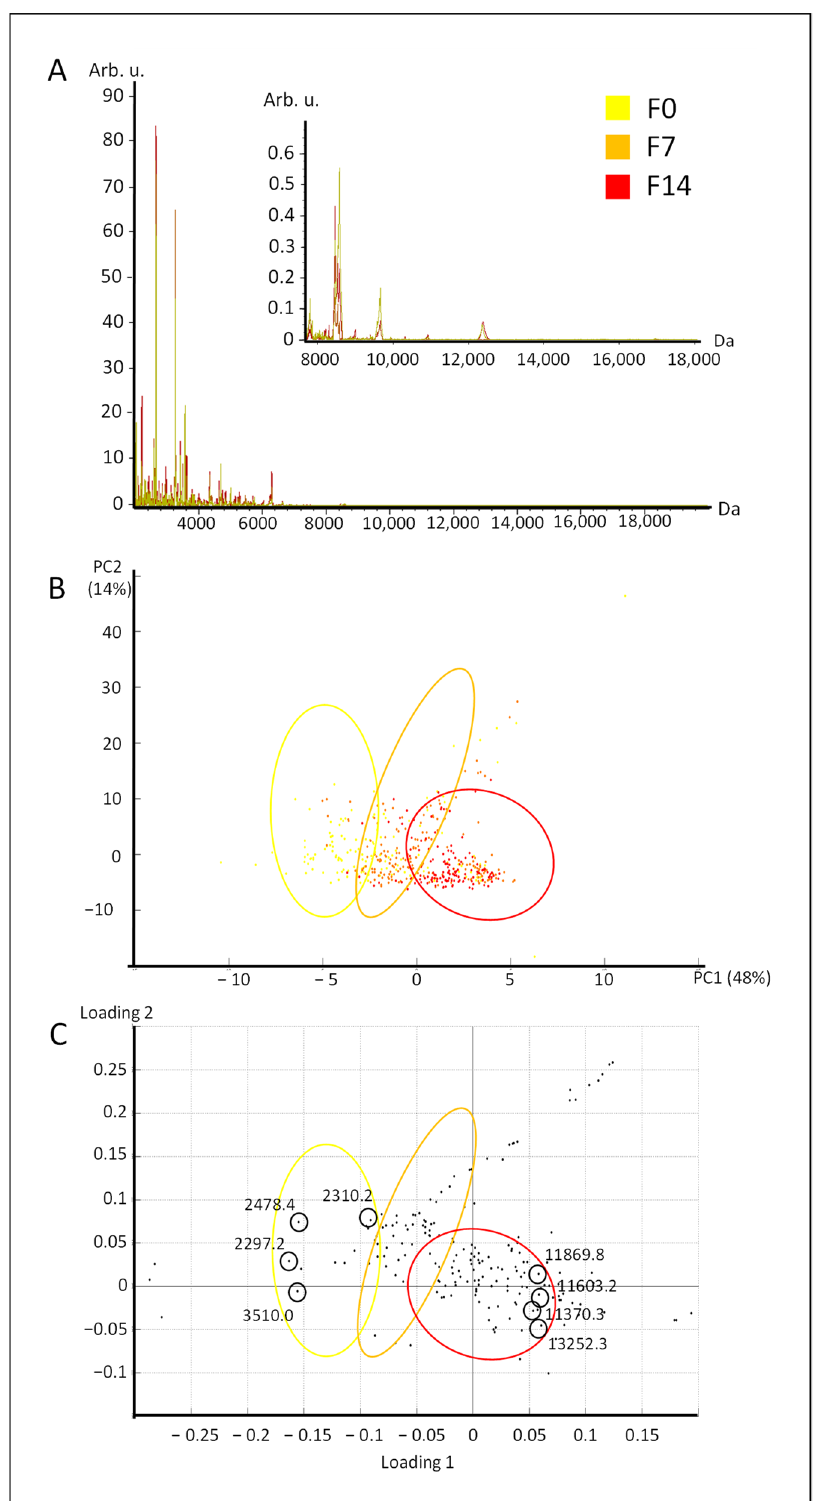
Figure 1. Spectral analysis of fresh livers stored for 0, seven, and 14 days. Mean protein spectra ( A ) from fresh livers stored 0 (F0, in yellow), 7 (F7, in orange), and 14 days (F14, in red). B. Score plot ( B ) and mass loading plot ( C ) of the PCA of protein spectra from fresh livers stored for 0, seven, and 14 days.